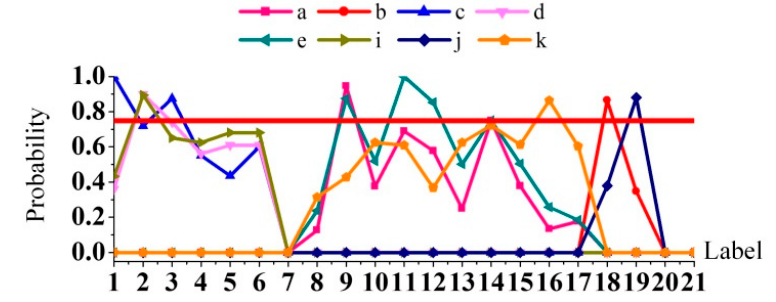
Figure 7. Labeling probability of load.